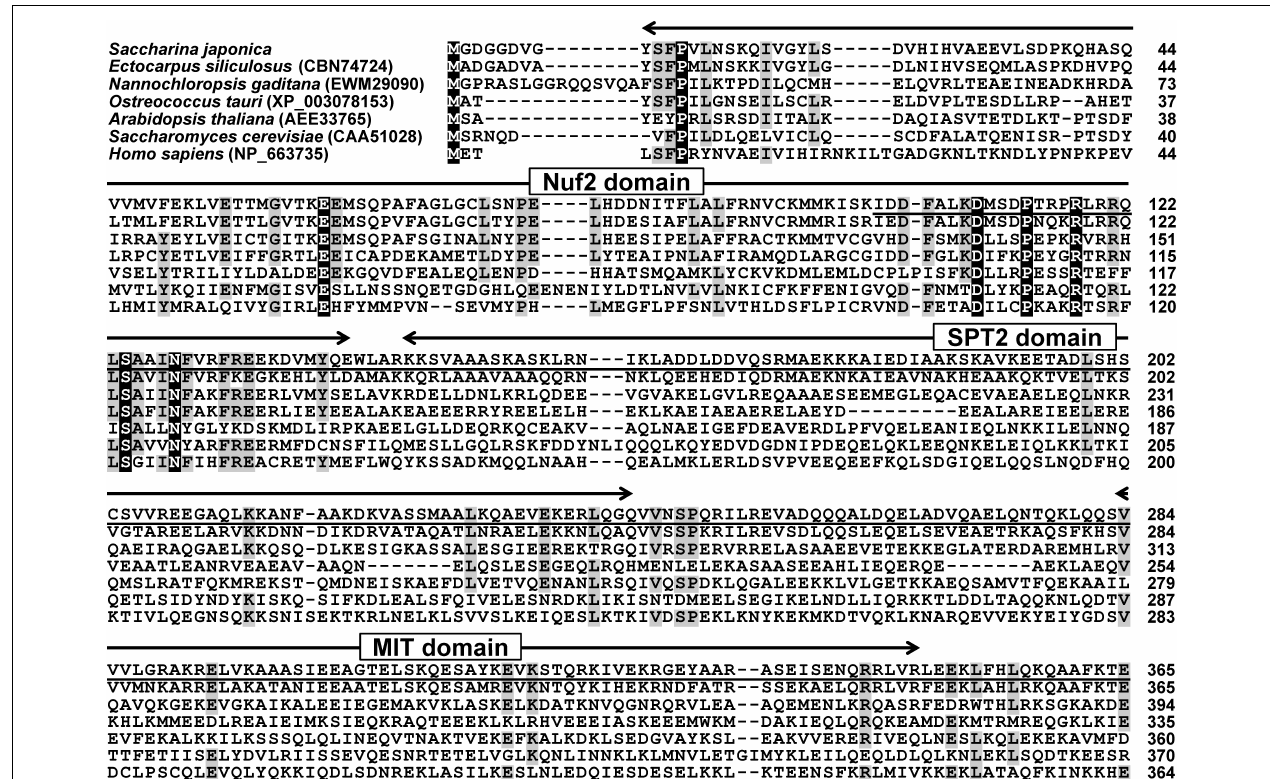
FIGURE 1 | Multiple sequence alignment of Nuf2ps from several organisms. Conserved residues and the residues with 70% identity are highlighted in black and gray, respectively. The underlined indicates Spc7 domain.